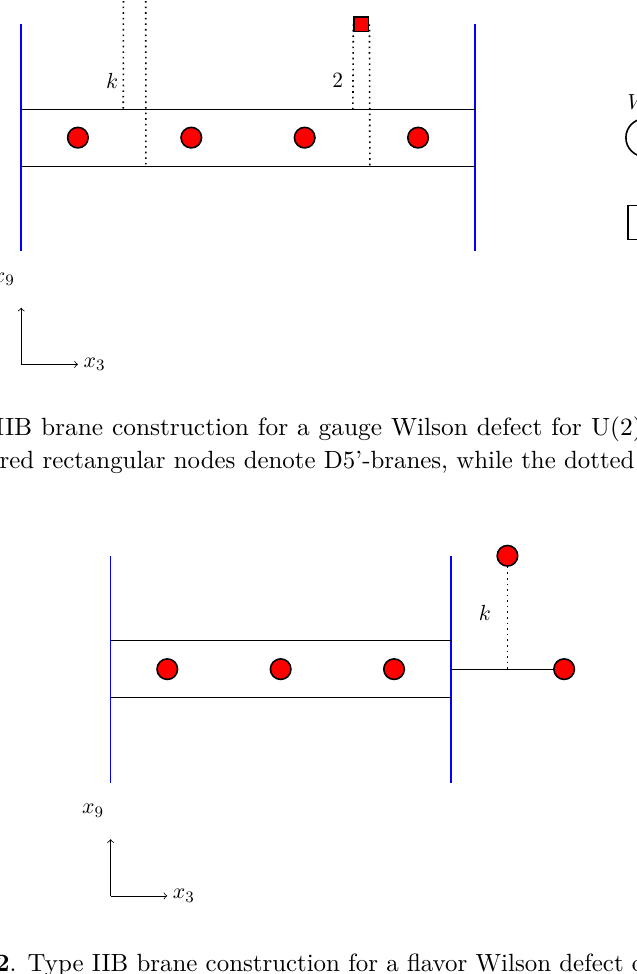
Figure 12 . Type IIB brane construction for a flavor Wilson defect of charge k